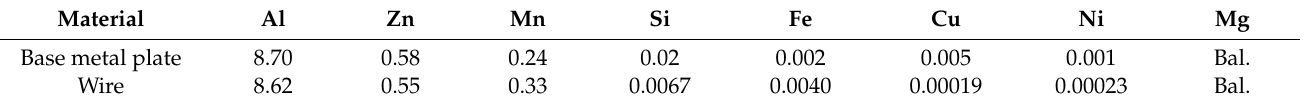
Table 1. Chemical composition of the substrate plate and wire (wt.